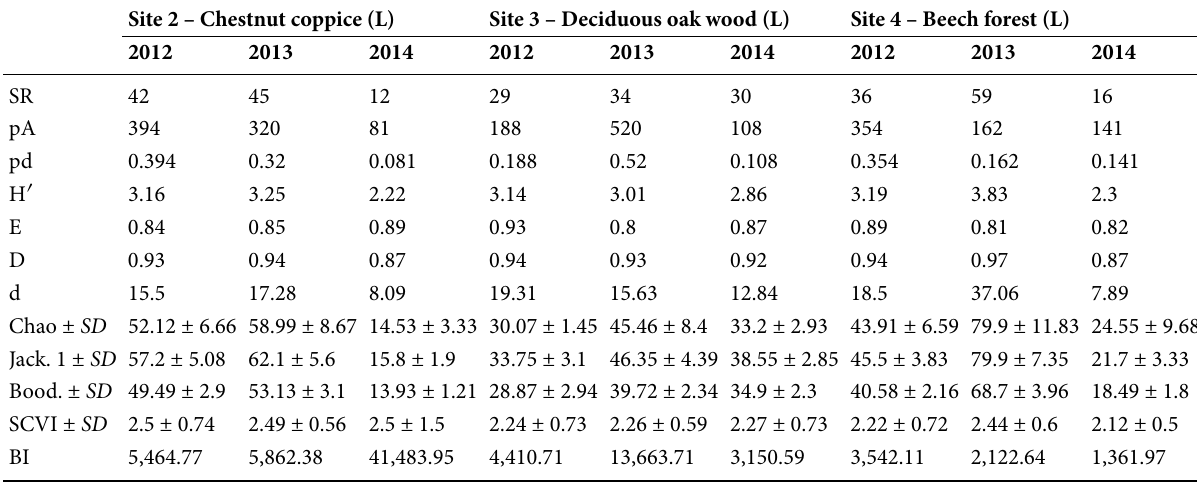
Table 4 Summary of biodiversity indices in S2, S3 and S4 over three consecutive years (2012–2014). Site 2 – Chestnut coppice (L)